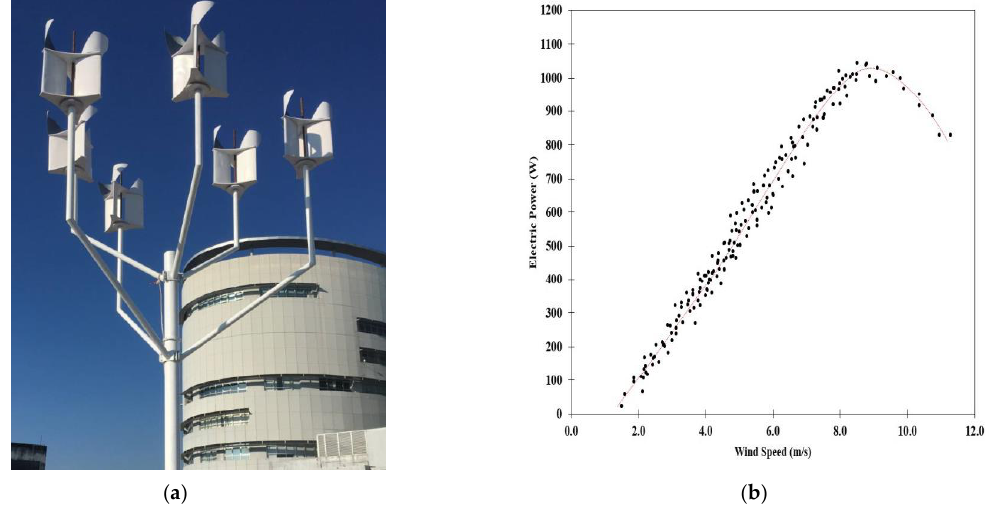
Figure 13. Shows the nanocomposite application in field test of a wind turbine tree system: ( a ) Savonius-Darrieus wind turbines tree, ( b ) Wind velocity (m/s). Table 4. Technical parameters of Tree Shaped Wind